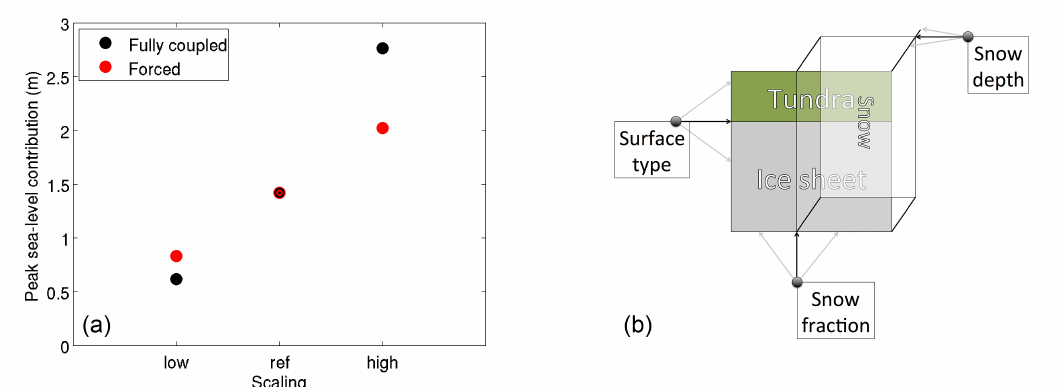
Figure 7. Scaling of sea-level contribution from the Greenland ice sheet as a function of temperature changes for the full model (black) and forced model (red) in comparison (a) . Schematic of the albedo parameterisation in the land model for (partially) ice-covered areas (b) , which is a function of the underlying surface type, snow fraction, and snow depth. See main text for